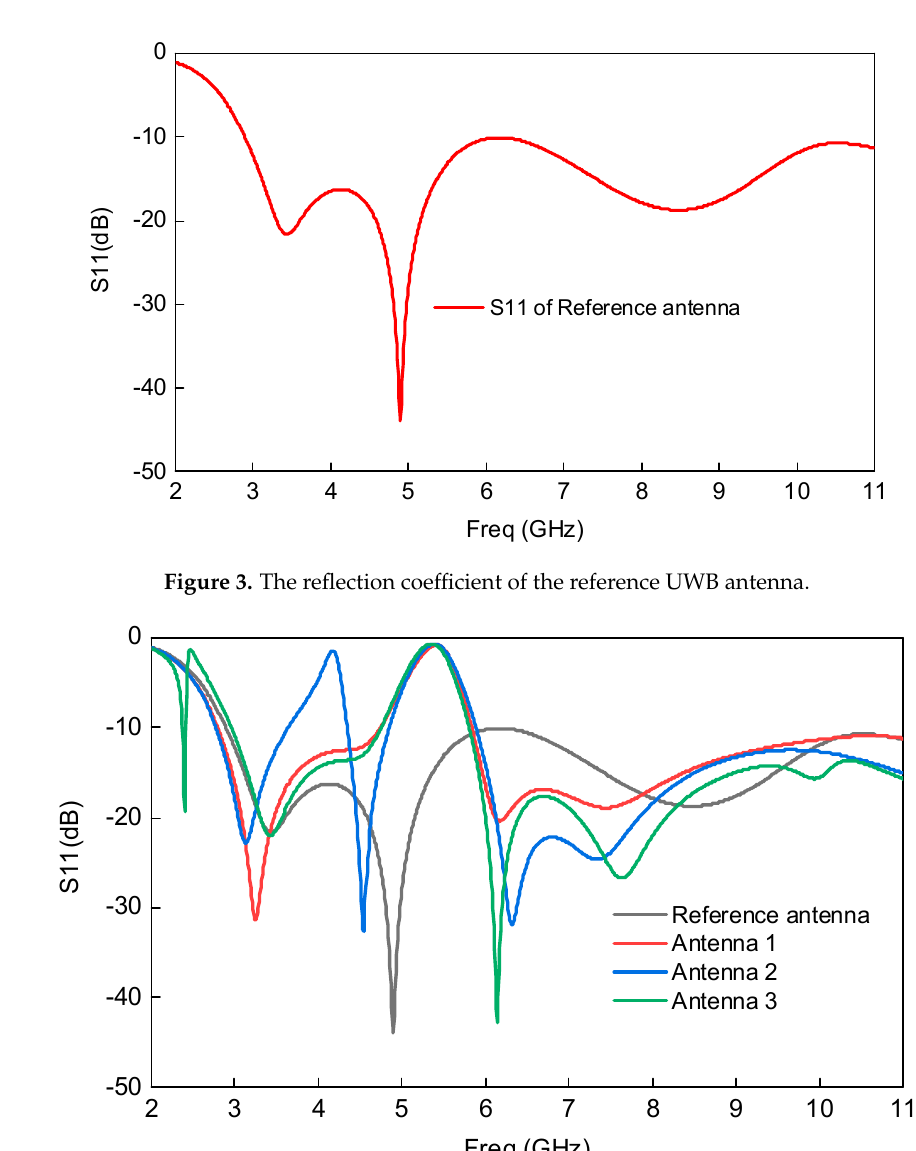
Figure 4. Comparison between the above-designed antenna’s behavior in terms of the reflection coefficient.